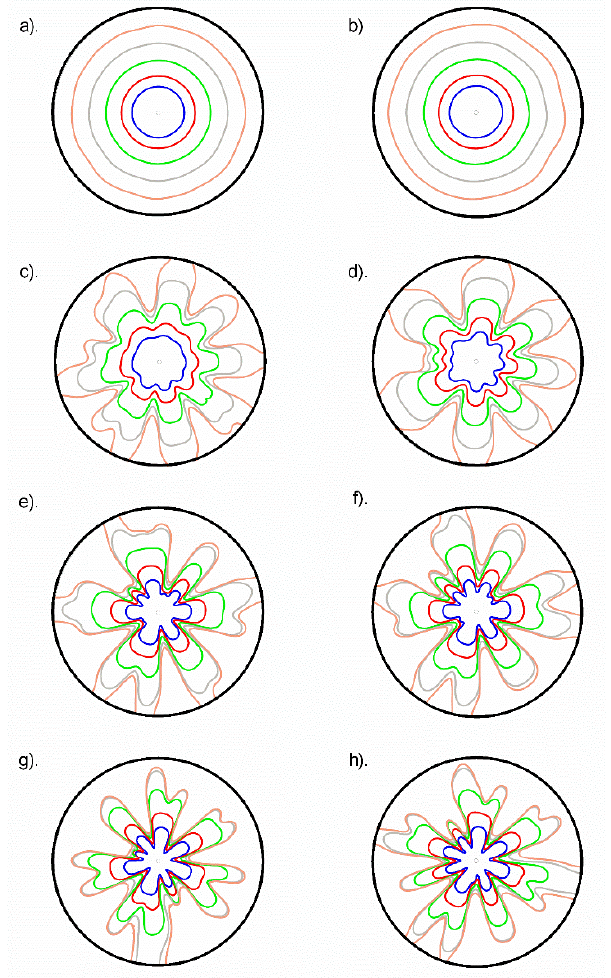
Figure 5. Temporal evolution of fingering for Darcy’s model (left column) and modified Darcy’s model (right column) for 𝑅𝑒 = 2.2 × 10 −3 and 𝑃𝑒 = 1.45 at different times: 𝑡 = 10 𝑠 (blue), 𝑡 = 20 𝑠 (red), 𝑡 = 40 𝑠 (green), 𝑡 = 70 𝑠 (grey), and 𝑡 = 110 𝑠 (orange). Values are changed with rows as 𝑅 = 2 for ( a , b ), 𝑅 = 4 for ( c , d ), 𝑅 = 6 for ( e , f ) and 𝑅 = 8 for ( g , h ).